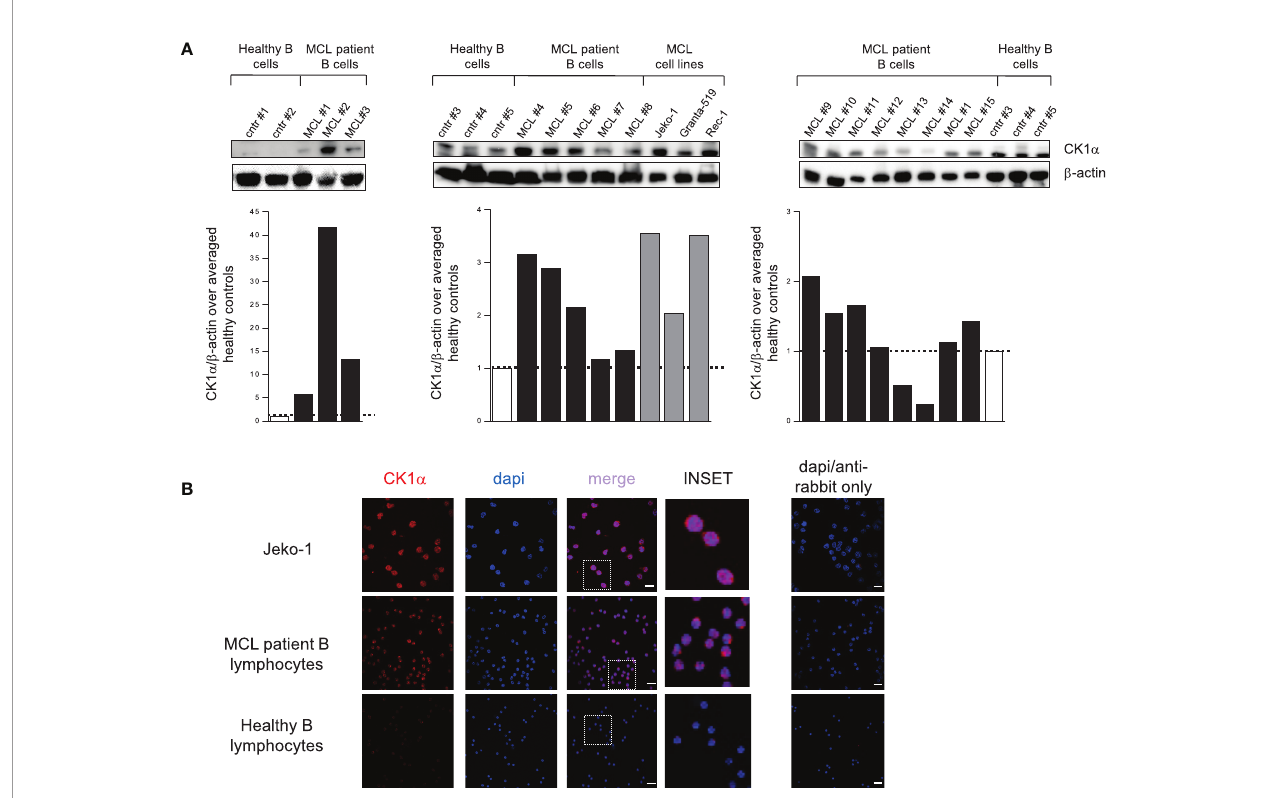
FIGURE 1 | CK1 a protein is overexpressed in MCL patients and cell lines compared to controls. (A) WB analysis (upper panel) and the corresponding densitometric values (lower panel) of CK1 a protein expression in puri fi ed B lymphocytes from 5 healthy buffy coats (white bars), from 15 MCL patients (black bars) and from the MCL cell lines Jeko-1, Granta-519 and Rec-1 (grey bars). b -actin was used as a loading control. For each blot, the densitometric values of CK1 a in MCL patients and cell lines are reported as arbitrary units over averaged healthy controls within the blot. (B) CK1 a cellular distribution along with DAPI staining in Jeko-1 cell lines, a MCL patient sample and healthy lymphocytes from buffy coat. CK1 a is detected by red fl uorescence and nuclei by DAPI. On the right panel staining with only Alexa fl uor 594-conjugated goat anti-rabbit secondary antibody merged with dapi is shown. Images were collected with 63X magni fi cation, oil objective. The insert shows a detail of the image. Scale bars =